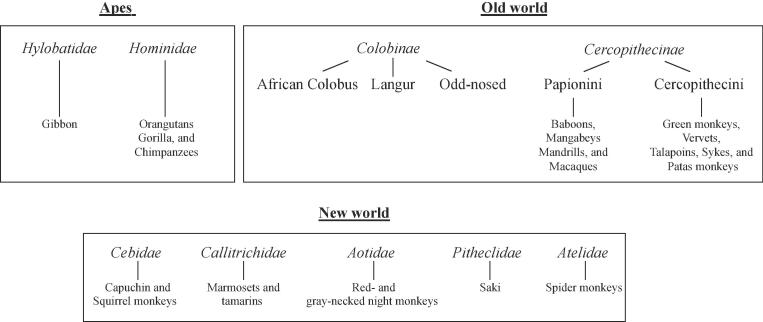
Primate phylogeny.